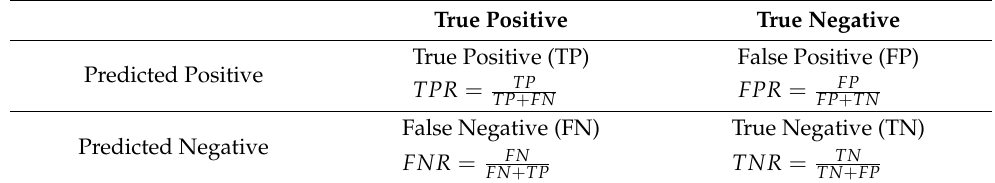
Table 2. Confusion Matrix adapted from